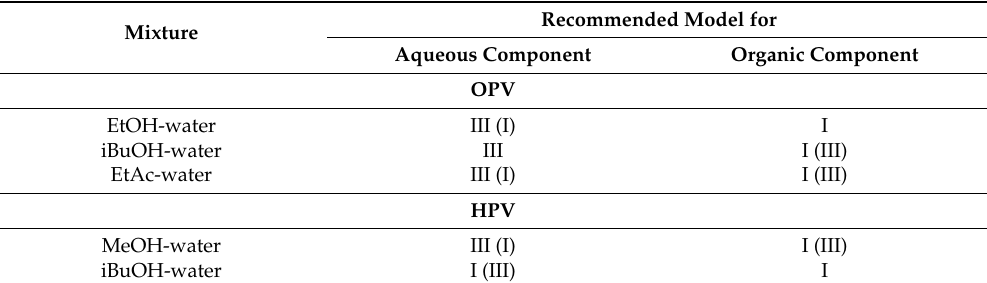
Table 5. Recommended model for examined